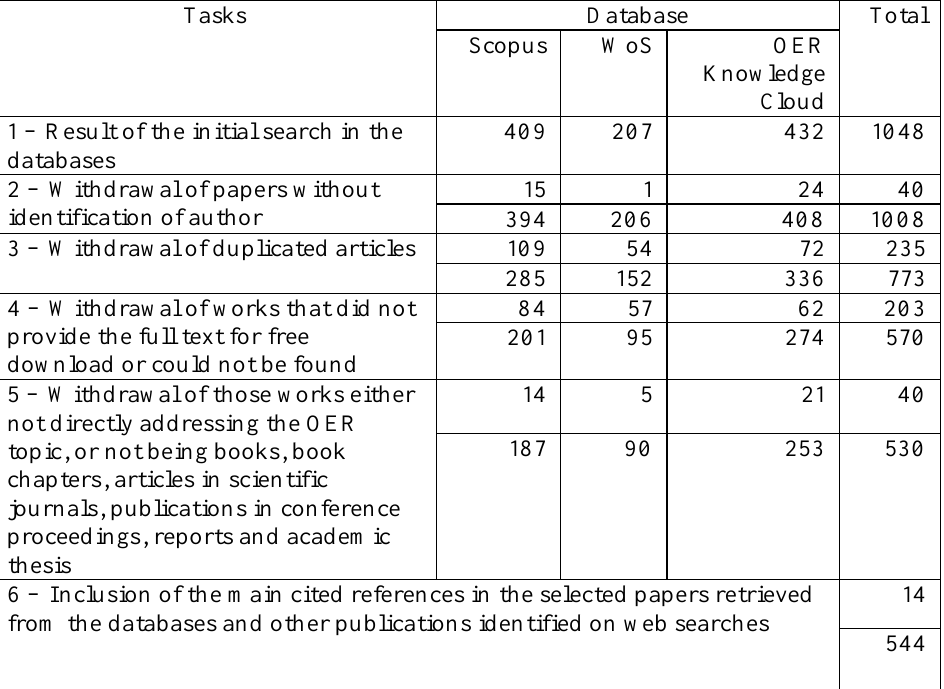
Process of Selection of Items for the Final Analysis and Number of Records Considered Tasks